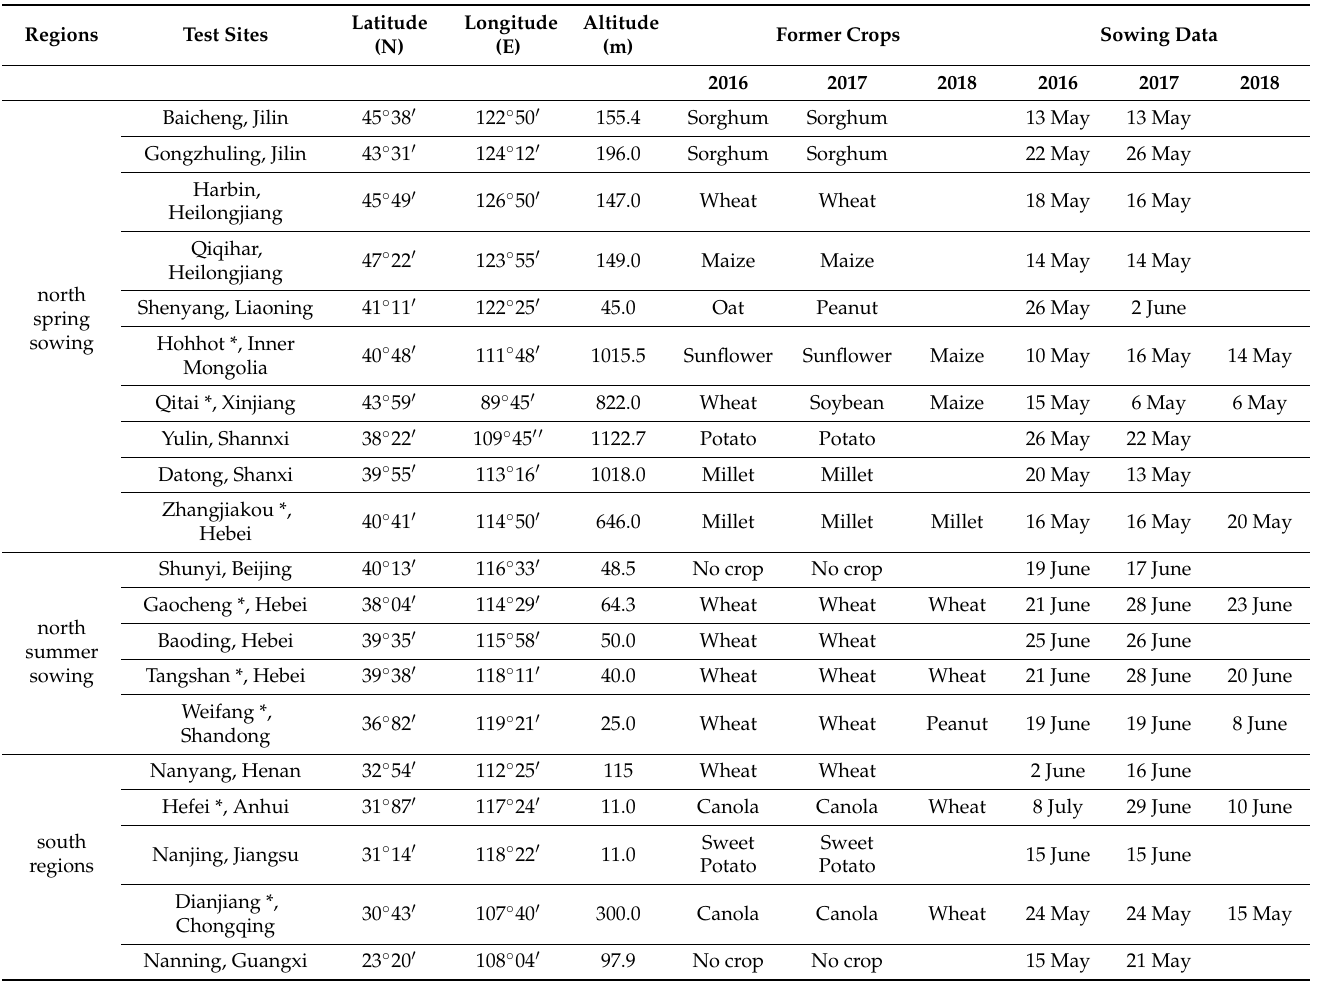
Table 1. Information on test sites of multi-ecological identification and production trials of the Chinese Agricultural Research System-Food Legumes program from